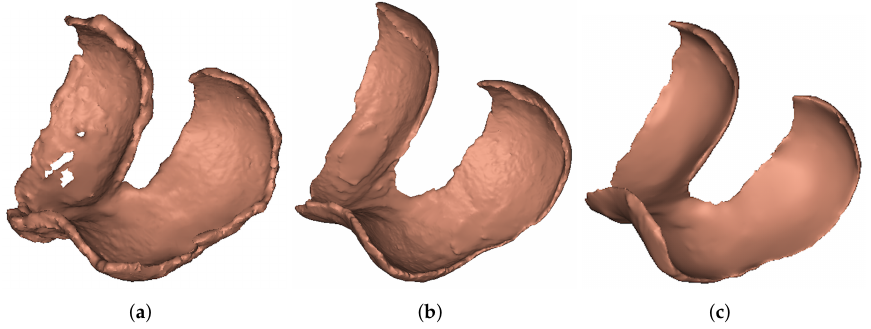
Figure 3. ( a ) Degenerative femoral cartilage, ( b ) traumatic femoral cartilage, ( c ) control femoral